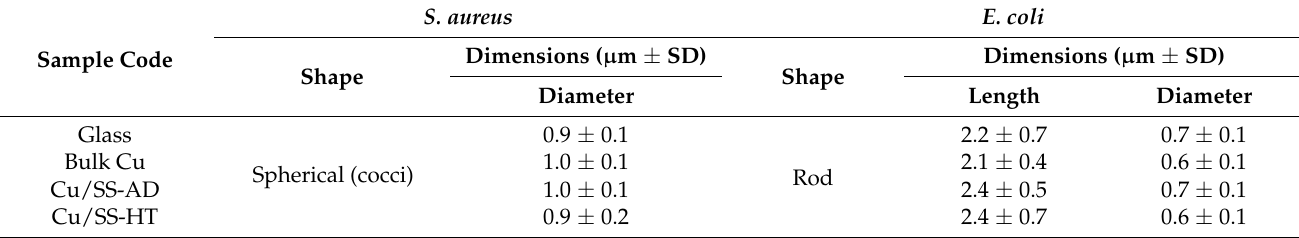
Figure 5. SEM images showing the morphology of S. aureus ( left-hand side ) and E. coli ( right-hand side ) bacterial cells attached to different Cu samples tested after 15 min exposure. The insets show high magnification images of the bacterial cells. Note: Yellow arrows indicate locations where bacterial cells are attached to the surface of the samples, and blue arrows indicate the cell debris produced by the bacterial cells. Table 5. The average dimension of bacterial cells attached to the surface of glass (control) and different Cu samples